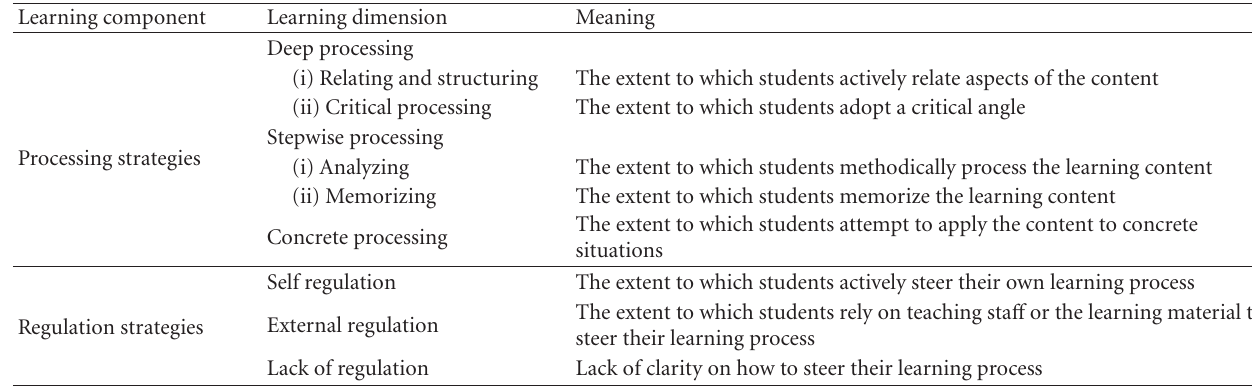
Table 1: Learning strategies and their meaning as conceived in the learning pattern